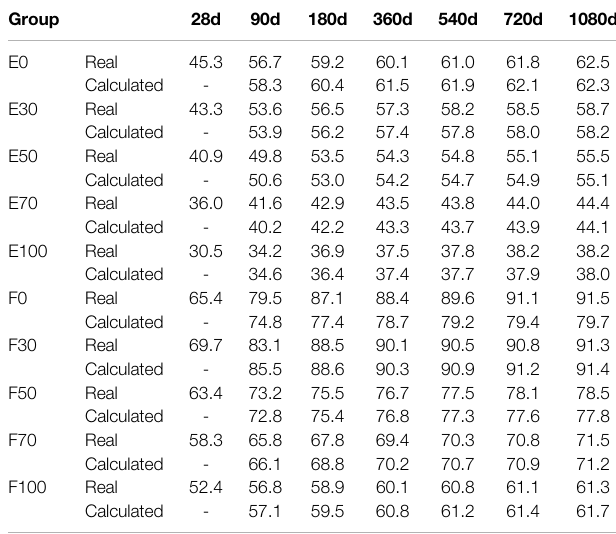
TABLE 10 | Relative compressive strength and age fi tting parameters. Group Content of iron tailings powder/%